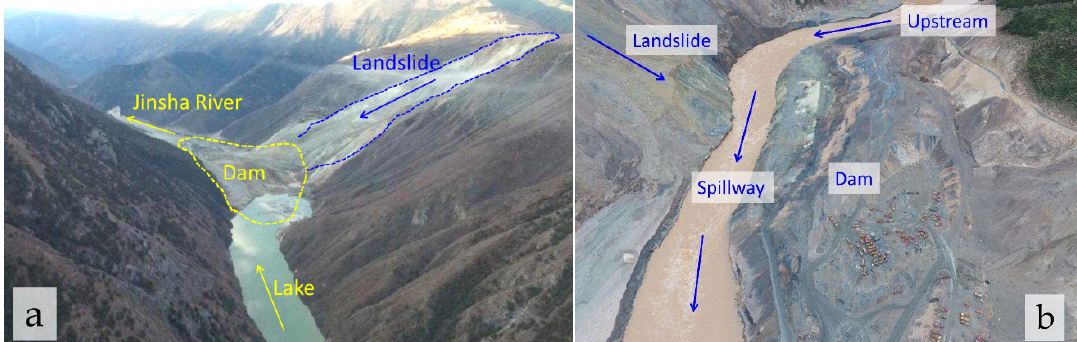
Figure 4. Baige landslide blocking the river on October 10, 2010. ( a ) is the panorama before the landslide dam break, and ( b ) is the top view of the dam crest when the landslide dam break. Table 4. Parameters of Baige landslide dam on Jinsha River in 2018.